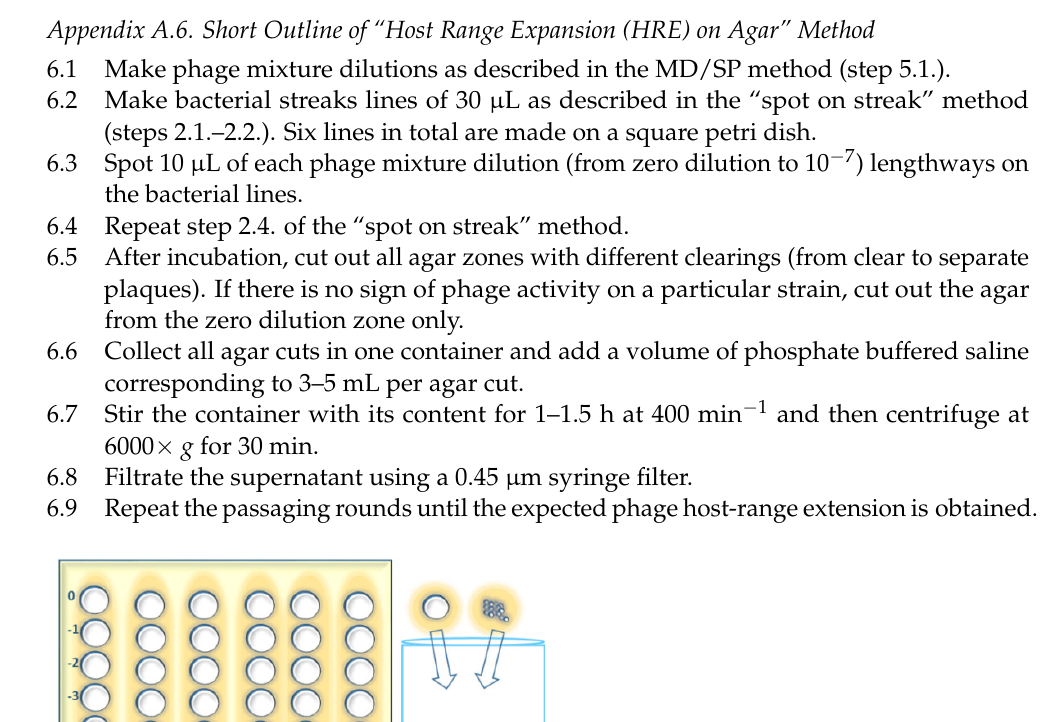
Figure A5. Diagram depicting the splitting of 2 µL spot in 4 smaller drops in the MD/SP method.